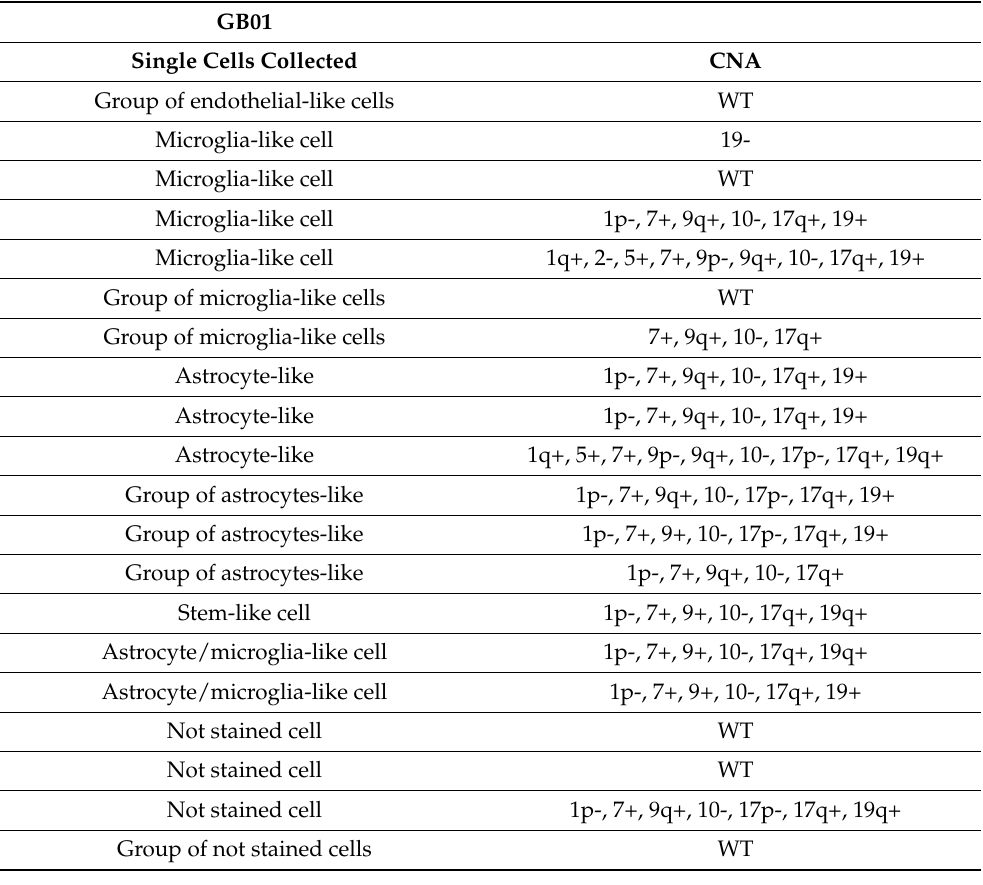
Table 2. CNAs results obtained after CNApp processing for single cells and groups of single cells collected in the GB01 sample.